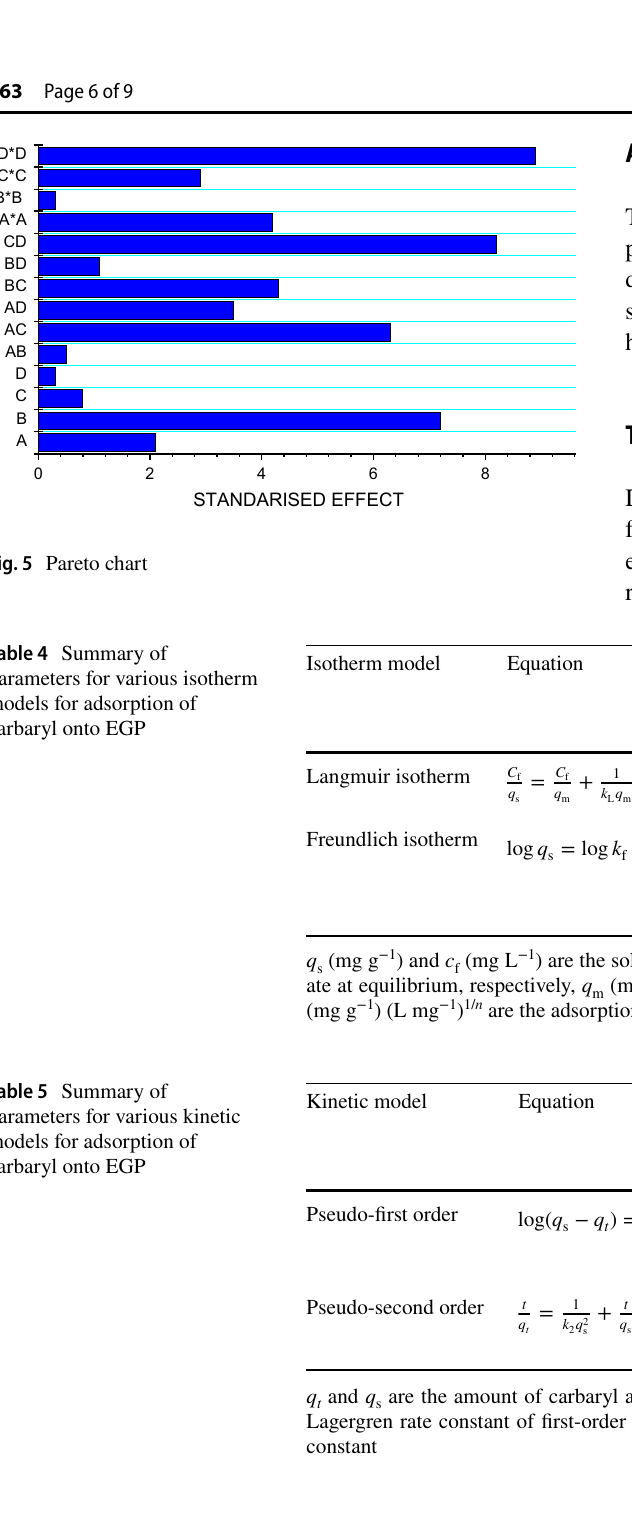
Table 6 Thermodynamic parameters for adsorption of carbaryl onto